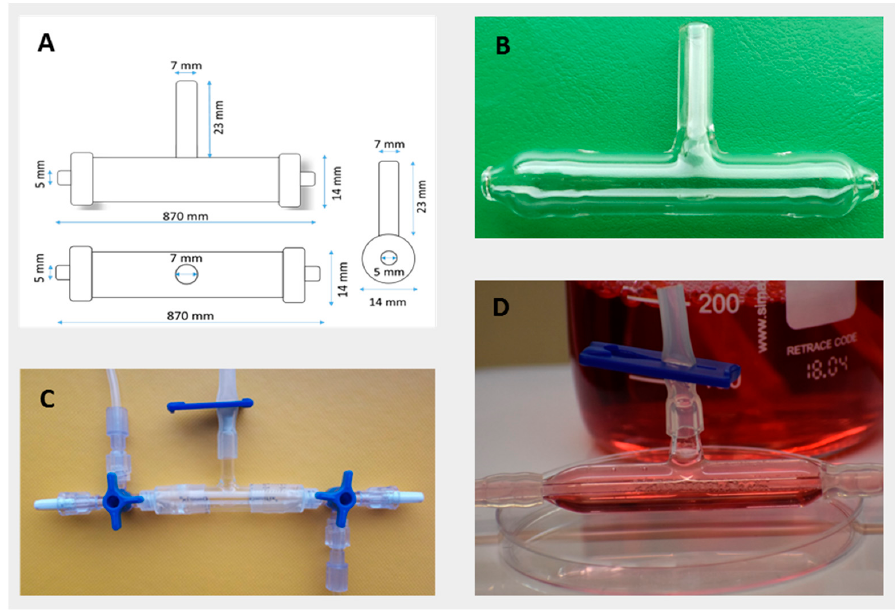
Figure 2. Plans for the bioreactor ( A ); photo of the empty bioreactor ( B ); bioreactor with tubing connection ( C ); and bioreactor filled with culture medium ( D ). connection ( C ); and bioreactor filled with culture medium ( D